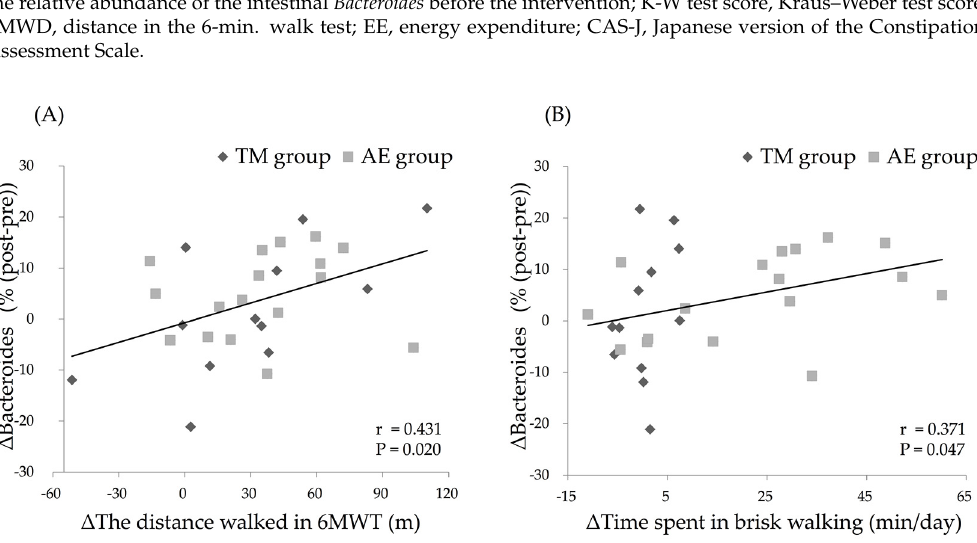
Table 4. Correlation coefficients in simple regression analysis between clinical factors and the changes in the relative abundance of intestinal Bacteroides following the exercise intervention in all subjects.